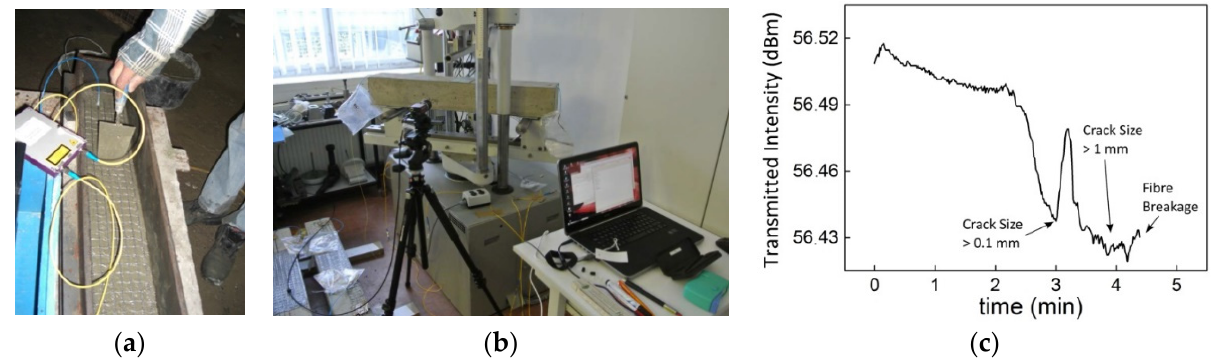
Figure 17. Embedding of the functionalized TNS into the concrete block ( a ), the experimental set-up ( b ), and the obtained results for the functionalized TNS to determine cracks of concrete structures ( c ) Reprinted with permission from Ref. [51]. Copyright 2016 Procedia Technology.